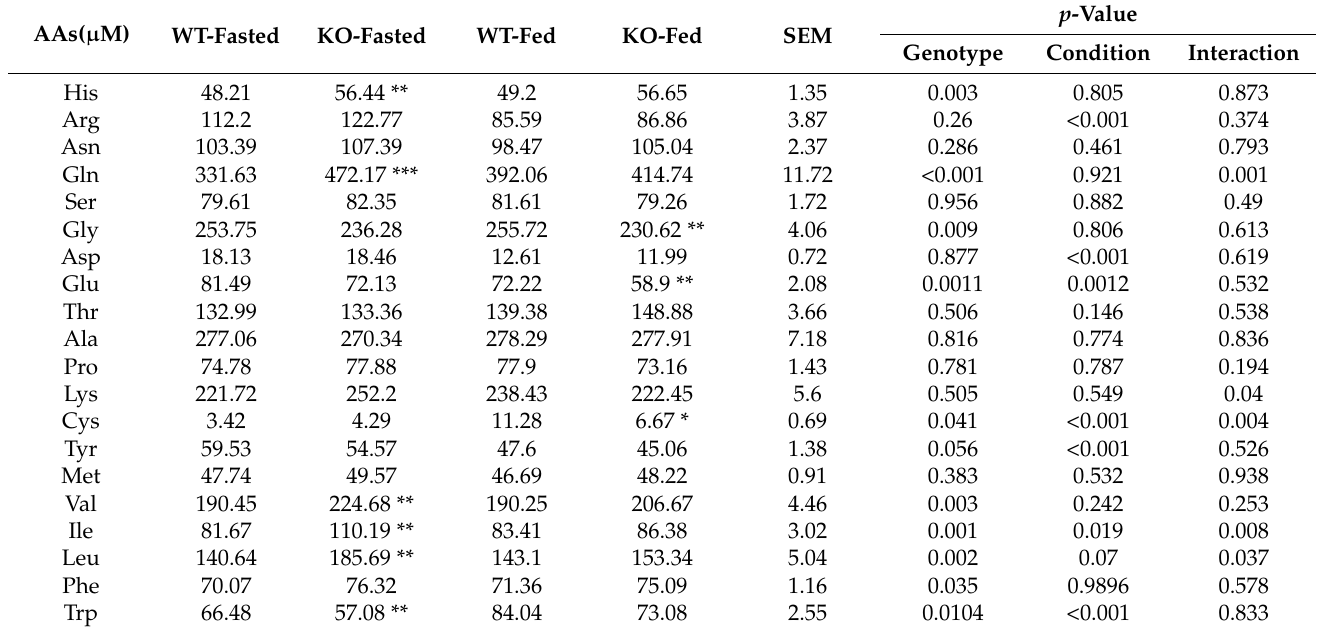
Table 1. Effects of GPRC6A deletion on serum AAs in mice under fasting and refeeding conditions.